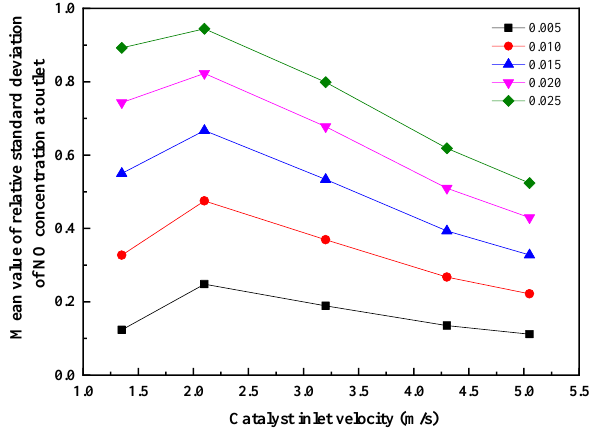
Figure 18. Relationship between different inlet velocity and the mean of center concentration deviation under different relative standard deviations of temperature.